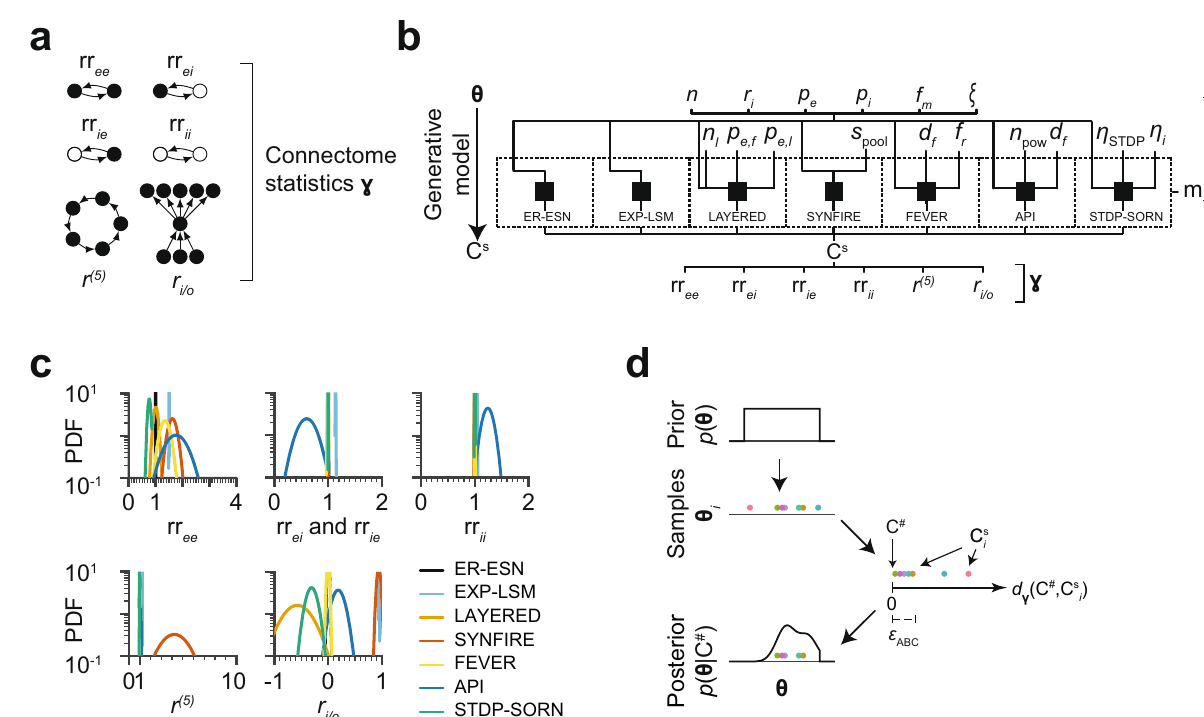
Fig. 3 Connectome statistics and generative models for approximate Bayesian inference. a Connectome statistics γ used for model distinction: relative excitatory-excitatory reciprocity rr ee , relative excitatory-inhibitory reciprocity rr ei , relative inhibitory-excitatory reciprocity rr ie , relative inhibitory-inhibitory reciprocity rr ii , relative cycles of length 5, r ð 5 Þ , and in-out degree correlation of excitatory neurons r i = o : b Generative model for Bayesian inference: shared set of parameters (top: number of neurons n , fraction of inhibitory neurons r i , excitatory connectivity p e , inhibitory connectivity p i , fractional connectome measurement f m , noise ξ ) and model-speci fi c parameters (middle: model choice m , number of layers n l , excitatory forward connectivity p e ; f ,